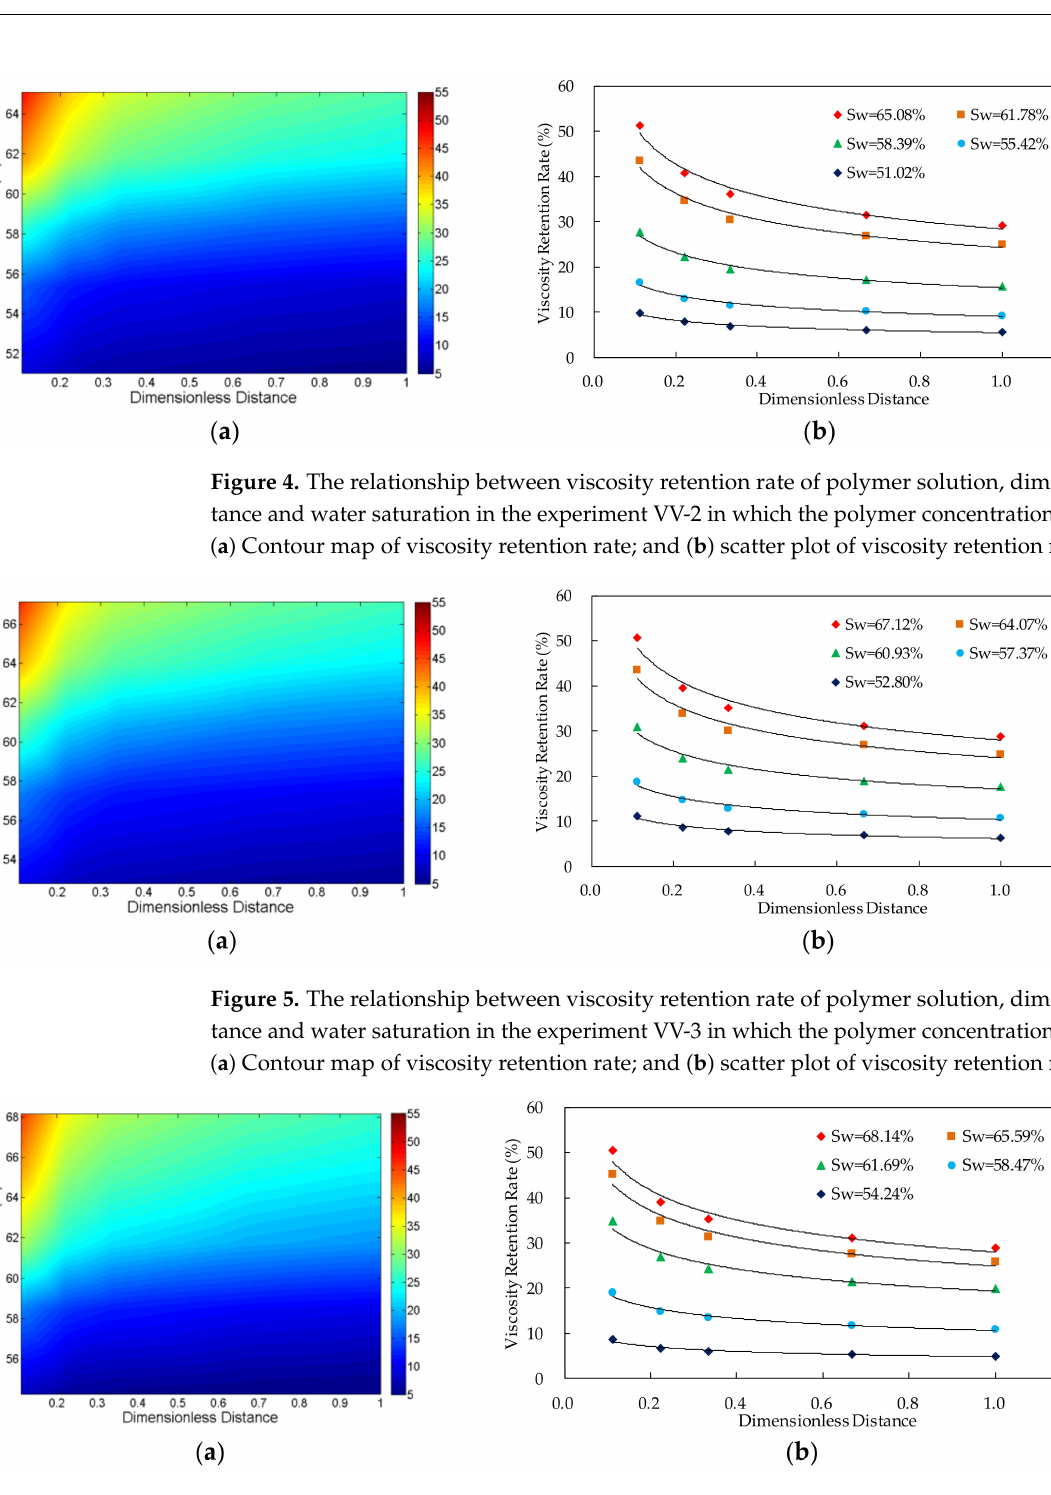
Figure 6. The relationship between viscosity retention rate of polymer solution, dimensionless dis- tance and water saturation in the experiment VV-4 in which the polymer concentration is 2000 mg/L. ( a ) Contour map of viscosity retention rate; and ( b ) scatter plot of viscosity retention